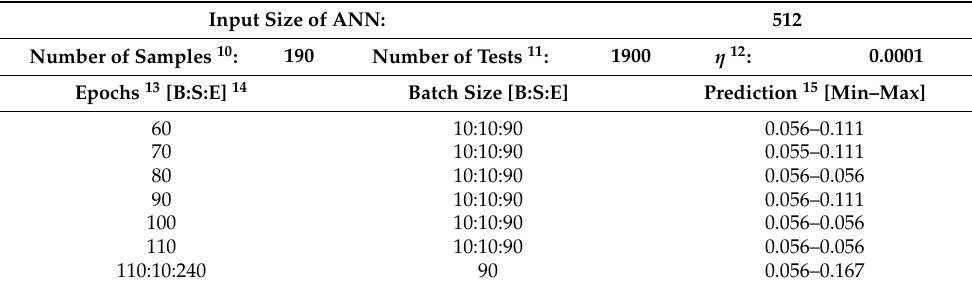
Table 7. Effectiveness of signal classification using CNN based on the PD vectors.